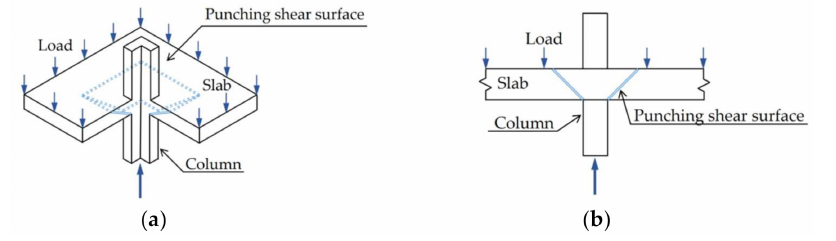
Figure 1. Punching shear failure mode of FRP reinforced concrete slabs. ( a ) Stereogram; ( b )